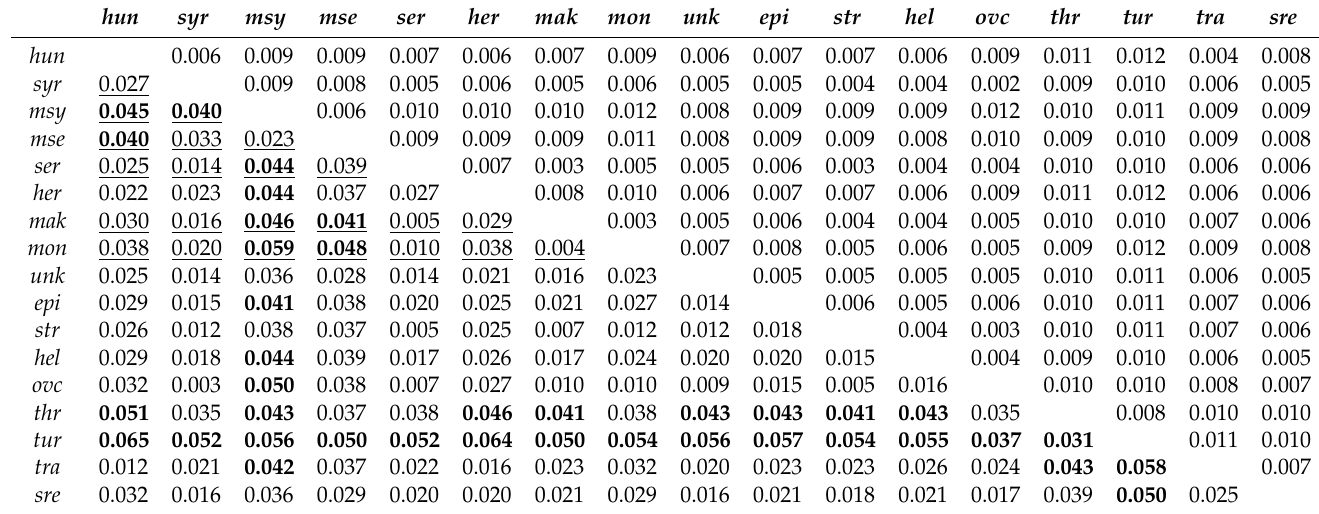
Bold—values equal to those recorded among Spalax species; underlined—seven reproductively isolated